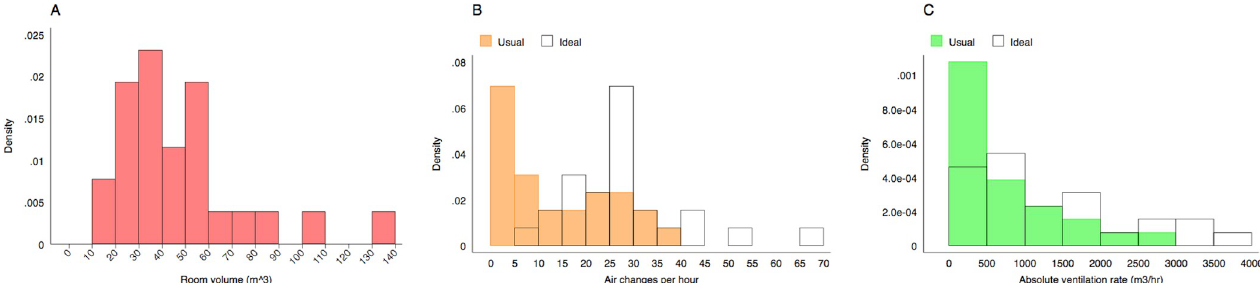
Fig 2. Histograms describing the distribution of room volumes (Fig 2A), the number of air changes per hour (Fig 2B) and the absolute ventilation rate (Fig 2C) in the 26 clinical spaces where we conducted tracer gas release experiments. Ventilation rates are described under usual conditions and ideal conditions (all doors and windows fully